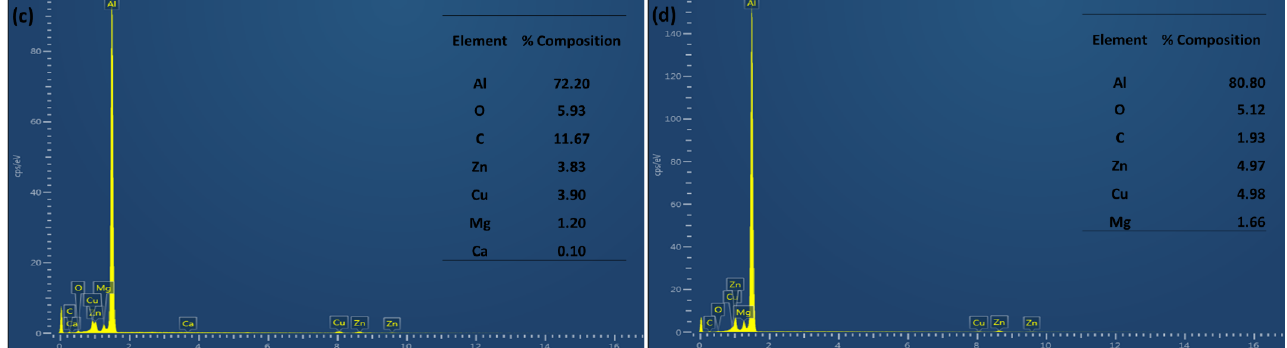
Figure 2. EDS analysis of the cast AMCs. ( a ) C1 (900 °C); ( b ) C2 (900 °C); ( c ) C3 (1100 °C); ( d ) C4 (1200 °C).